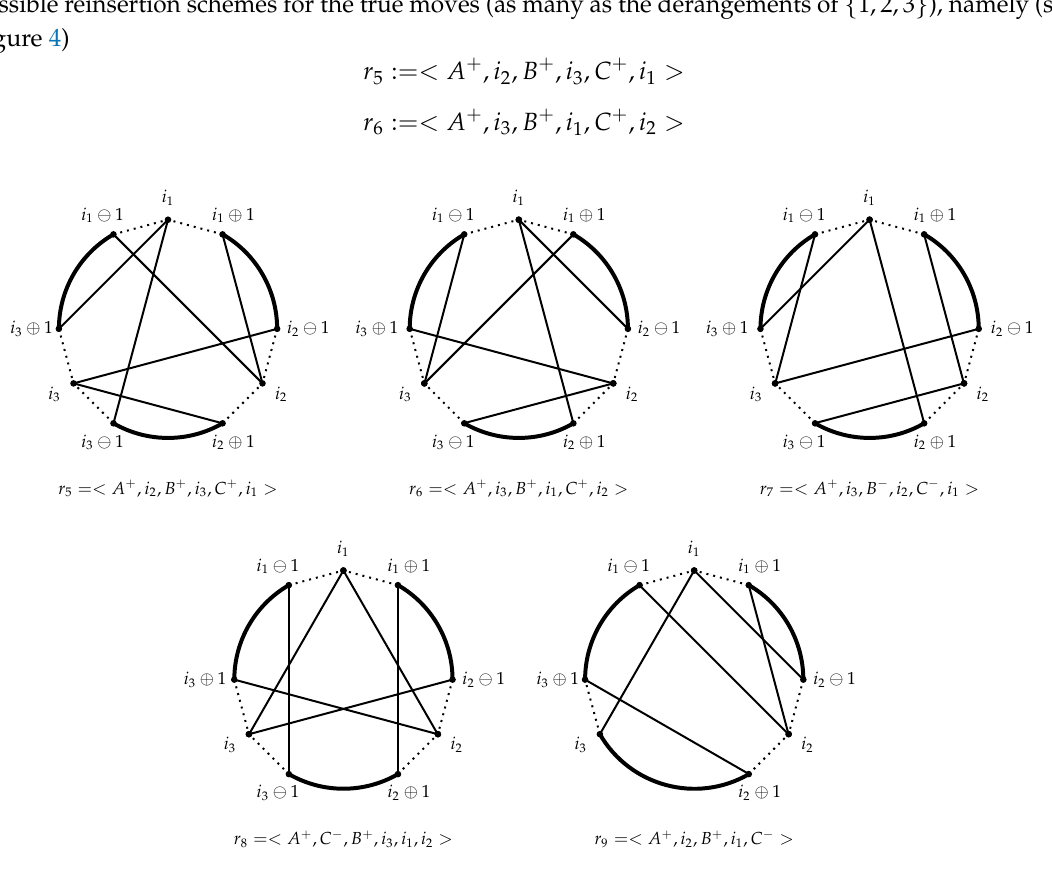
Figure 4. The reinsertion schemes of some special cubic